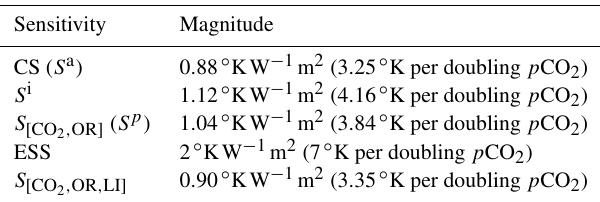
Figure 9. Factorization of the zonal-mean mid-Pliocene minus PI temperature anomaly computed using the 1-D EBM (dashed gray) into contributions arising from changes to cloud albedo (red), cloud emissivity (purple), surface albedo (blue), greenhouse gas concen- trations (including water vapor; green), and the total meridional heat transport (yellow). The solid gray line is the mid-Pliocene minus PI temperature anomaly computed directly from the GCM output. The dashed black line is the sum of the aforementioned individual con- tributions and is seen to almost perfectly overlap the total anomaly computed from both the EBM and the GCM. The abscissa is linear in the sine of latitude. Table 4. Various measures of climate sensitivity calculated from our